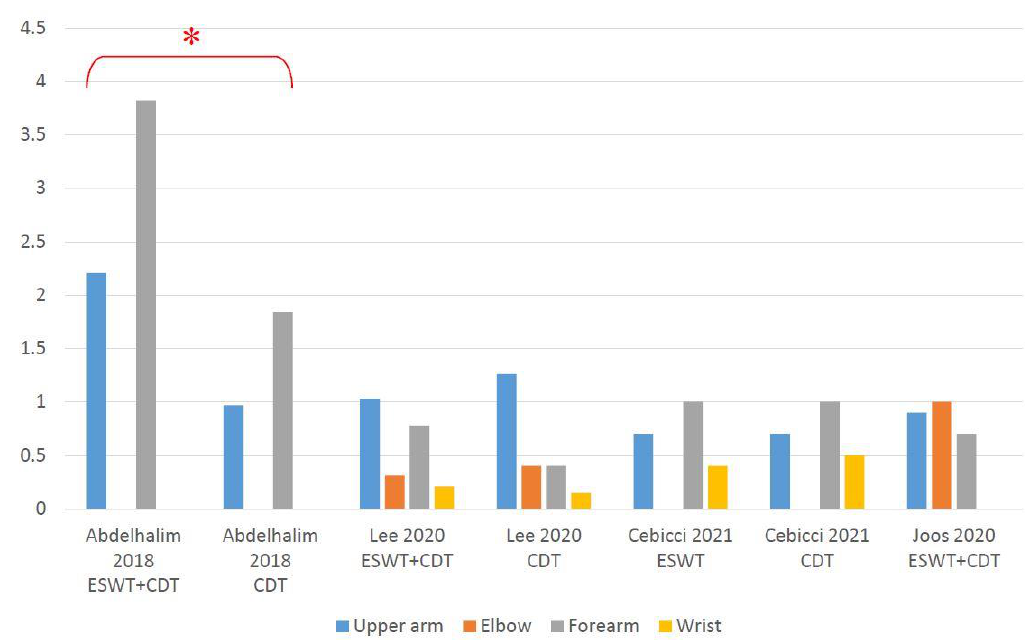
Figure 5. Absolute arm circumference change (cm) from baseline at post-treatment. * Significant inter-group difference. Table 5. Outcome measurements of the volume of included studies for ESWT in BCRL.